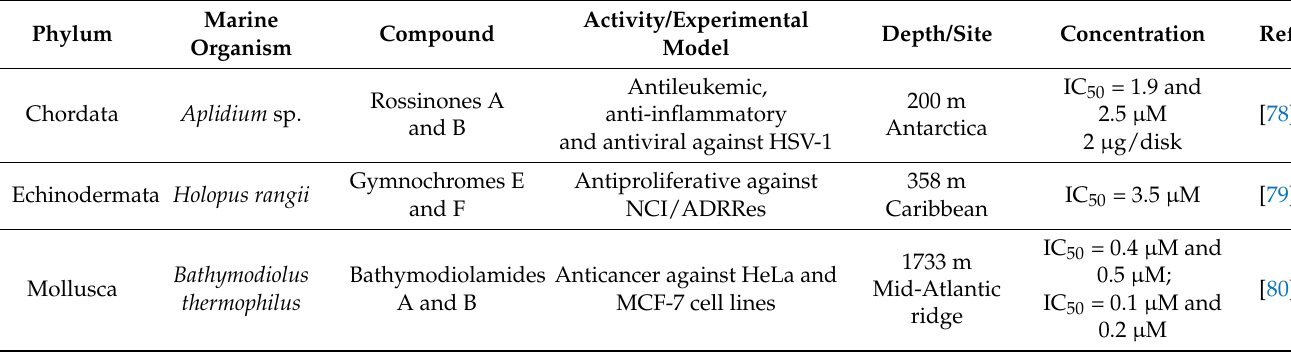
Table 6. Synopsis of new natural products isolated from deep-sea